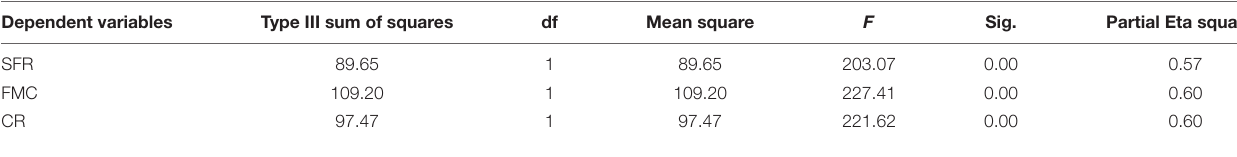
TABLE 10 | Results of test of between-subjects